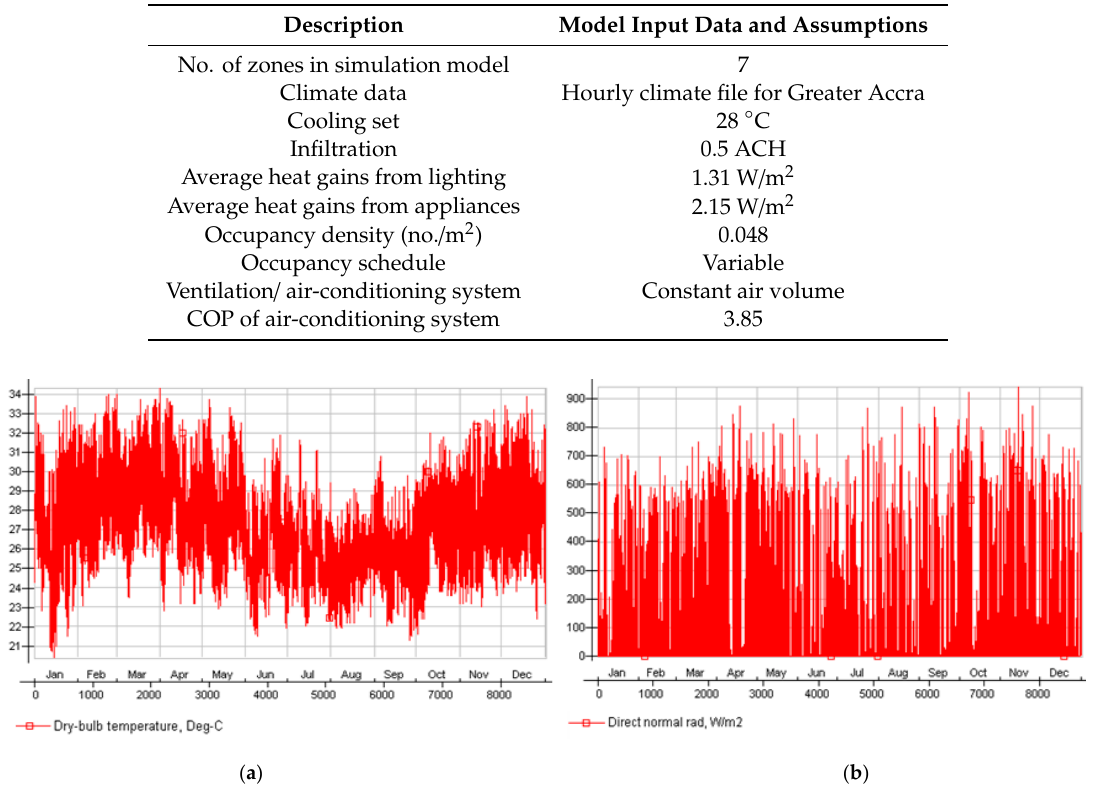
Figure 3. Average hourly dry-bulb temperature ( a ) and direct normal solar radiation ( b ) for Accra for the recent climate of